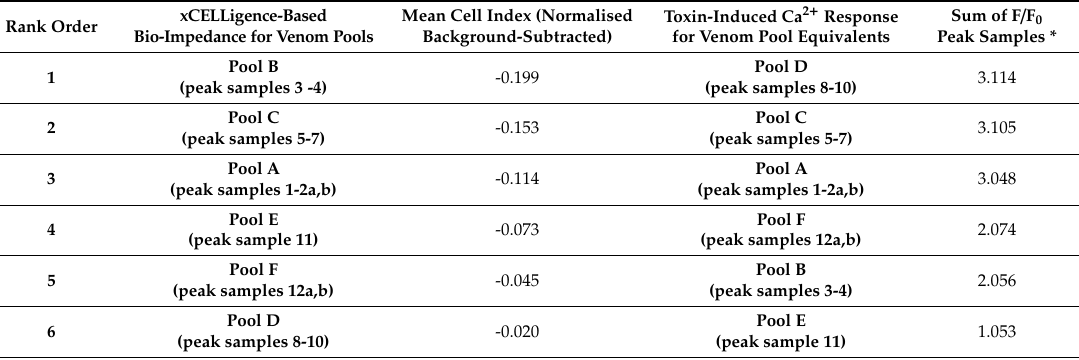
Table 1. Comparison of rank orders of potency between the reduction in bioimpedance evident five minutes after application of Australian scorpion Hormurus waigiensis venom fractions and the Ca 2 + response in GCaMP5G-RyR1-HEK293